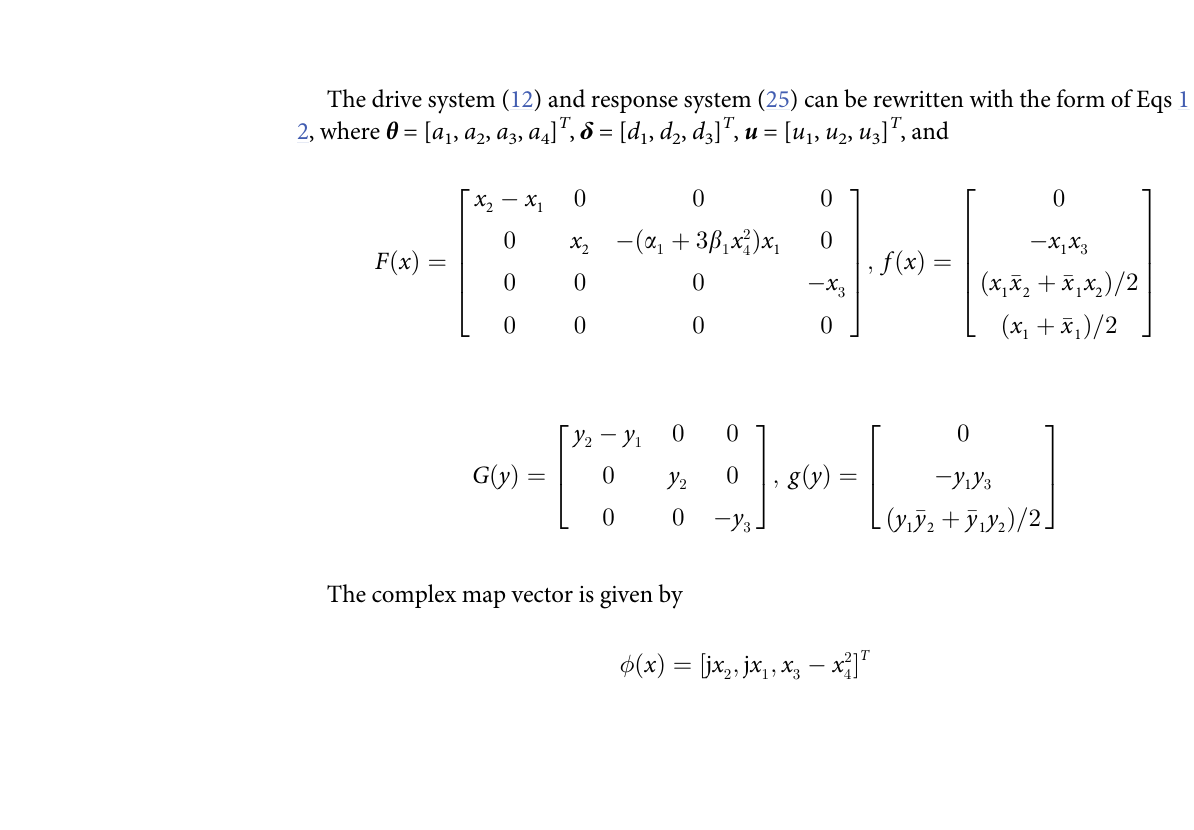
PLOS ONE | DOI:10.1371/journal.pone.0152099 March 24,